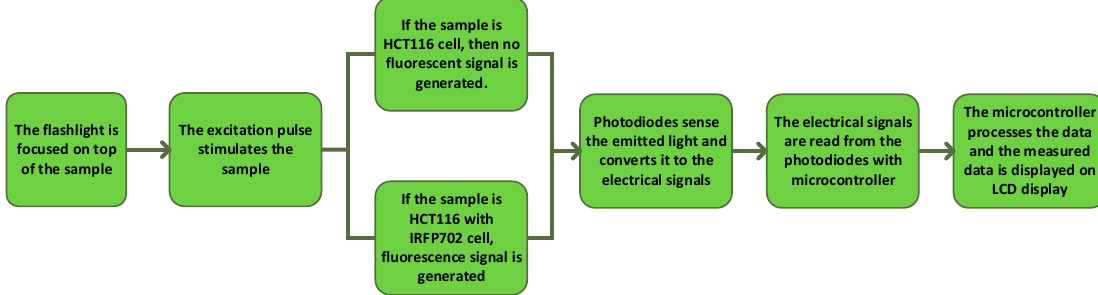
Figure 6. Flowchart showing the operating procedure of the device.